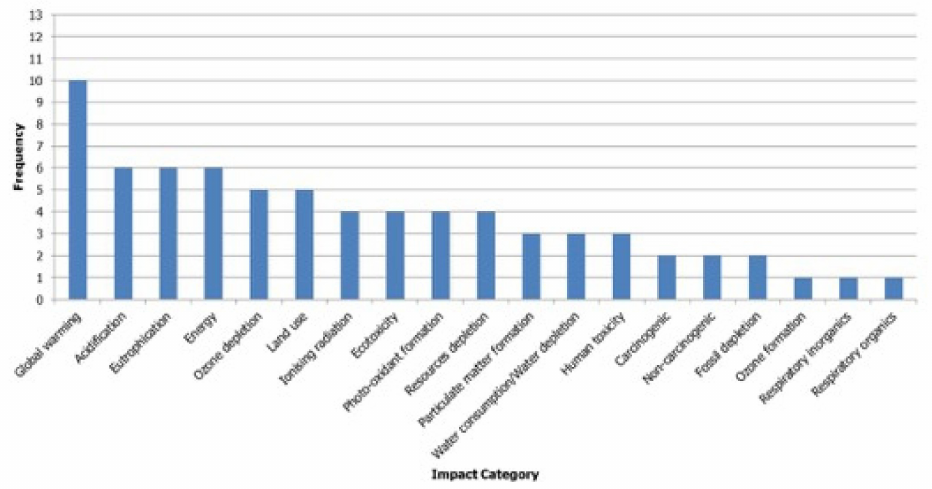
Figure 4. Frequency of the different environmental impact categories considered in 13 LCA studies on stationary batteries